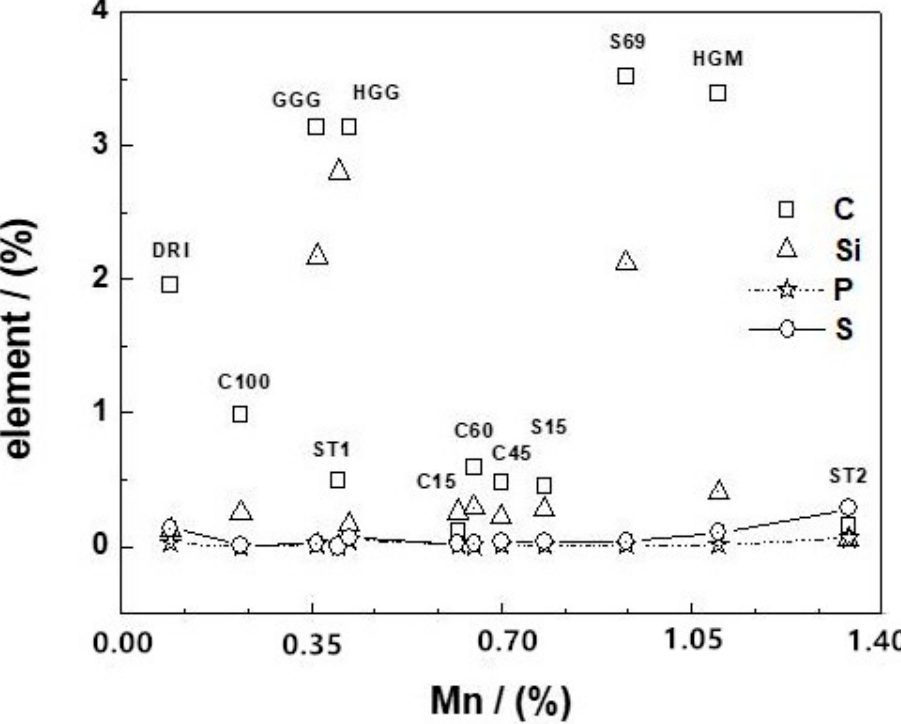
Figure 1. Distribution of carbon (C), silicon (Si), phosphorus (P), and sulfur (S) in the used iron materials as a function of their manganese content (% Mn). The represented lines (for P and S) are not fitting functions but just join the points to ease visualization. The codes of the individual materials are indicated on the curve for carbon content based on data from Table 3.